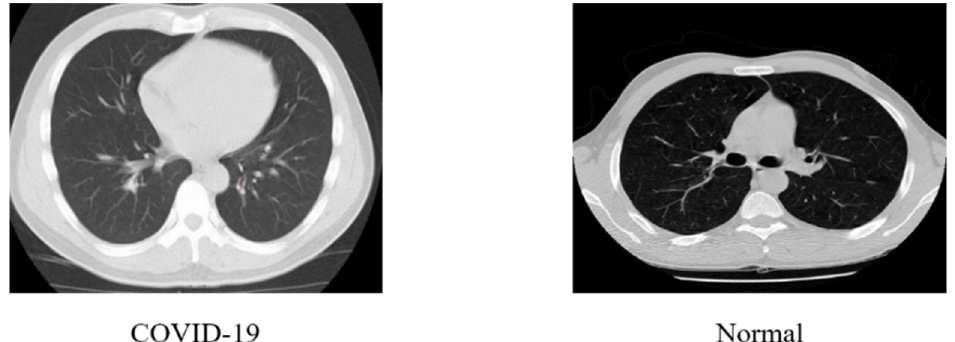
Figure 4. CT scan images of COVID-19 and healthy patients.